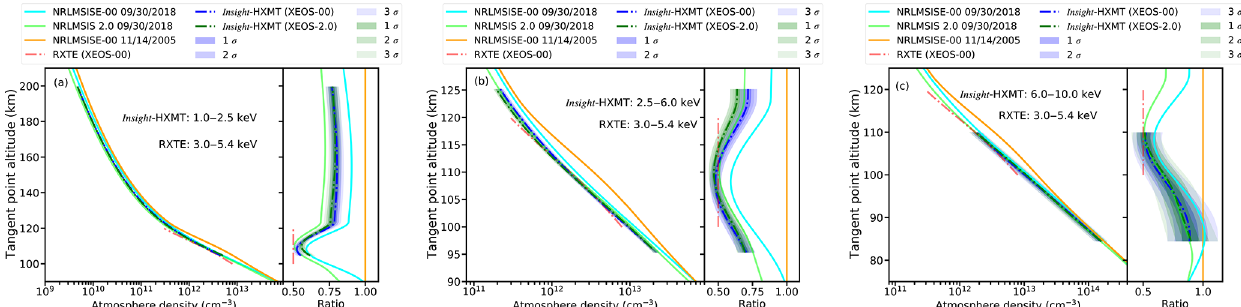
Figure 11. Panel (a) shows the comparison between the retrieved density profile in the altitude range of 105–200km based on the XEOS method and the NRLMSISE-00 and NRLMSIS 2.0 model predictions as well as the previous retrieved results based on PCA/RXTE. Panel (b) shows the comparison between the retrieved density profile in the altitude range of 95–125km based on the XEOS method and the NRLMSISE-00 and NRLMSIS 2.0 model predictions as well as the previous retrieved results based on PCA/RXTE. Panel (c) shows the comparison between the retrieved density profile in the altitude range of 85–110km based on the XEOS method and the NRLMSISE-00 and NRLMSIS 2.0 model predictions as well as the previous retrieved results based on PCA/RXTE. Right sub-panel of each panel: all density profiles are normalized to the NRLMSISE-00 density profile on 14 November 2005, in order to visually compare the differences between the various density profiles.